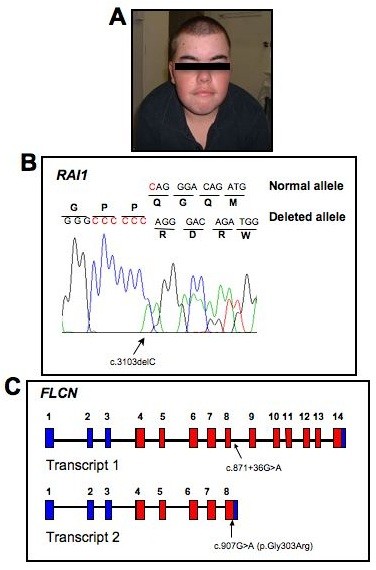
Mutation screening of SMS324 for RAI1 and FLCN. A.  Photograph of SMS324 at 18y, exhibiting features characteristic of SMS.  B.  DNA chromatograph of the normal allele and the c.3103delC change identified, resulting in a frameshift in the mutant allele.  This mutation is located within a heptameric C-tract (red C’s in the normal allele).  C.  Representation of the gene structure of FLCN transcript variant 1(top) and transcript variant 2 (bottom).  Non-coding exons are blue while coding exons are red.  The FLCN polymorphism identified in this patient is localized with arrows in both transcript variants and is numbered accordingly.